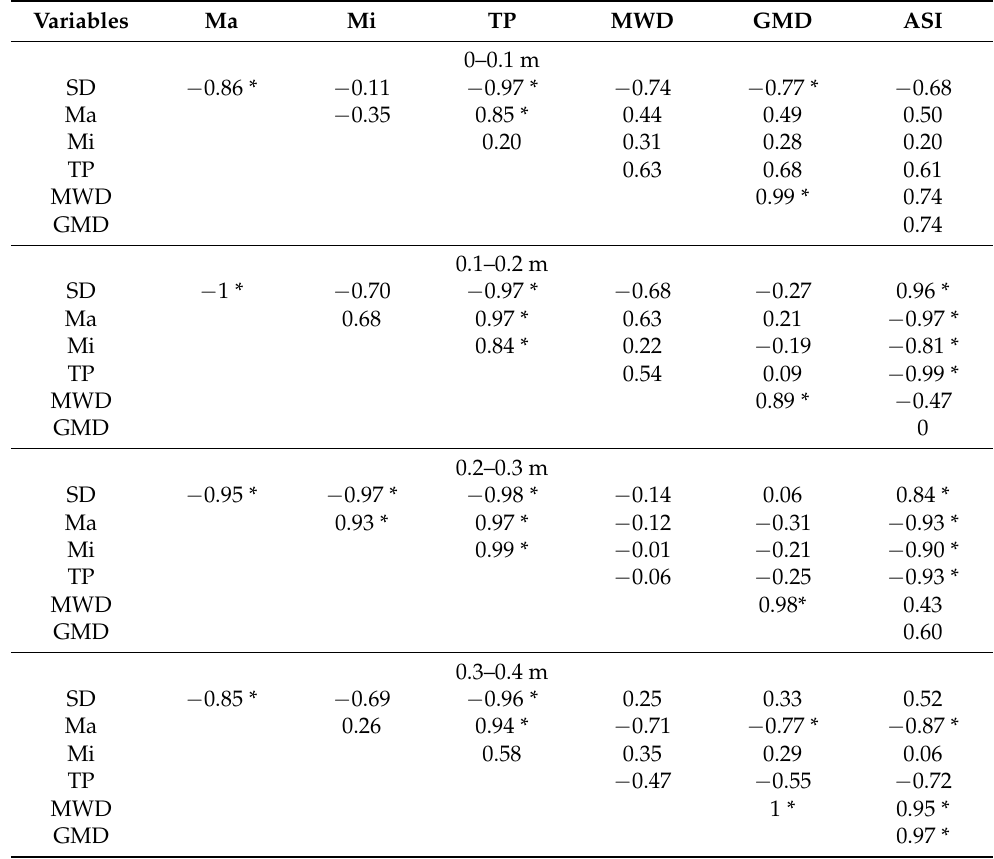
Table 3. Pearson’s correlations between soil physical attributes under different cover crops and Cerrado native area (0–0.4 m soil